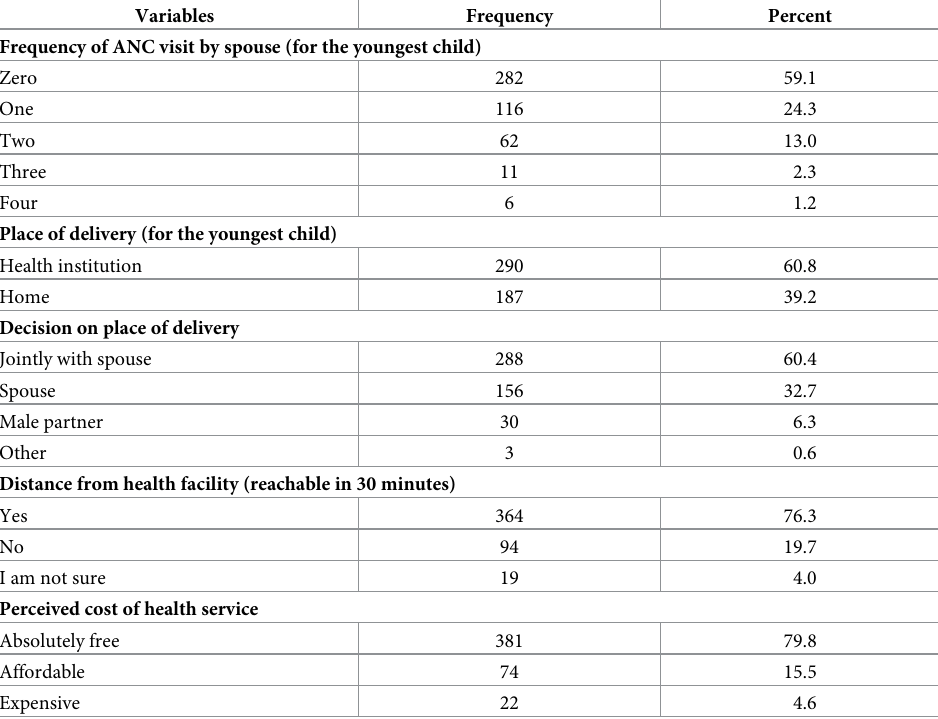
Table 3. Health service utilization and accessibility related characteristics of respondents in Debre Tabor town, North-West Ethiopia, 2019 (n = 477). Variables Frequency